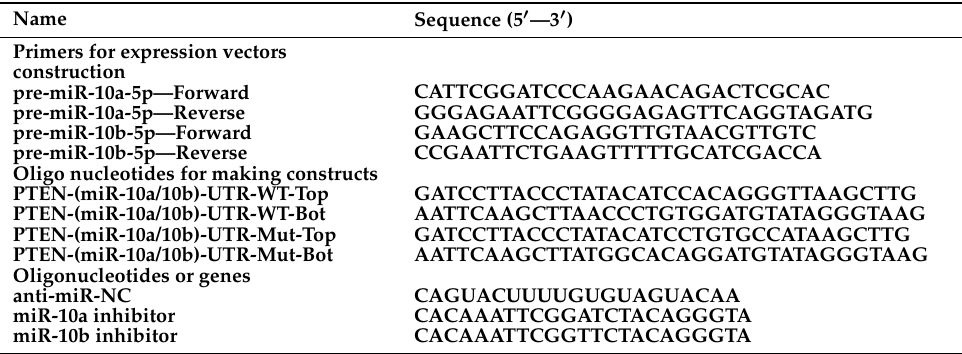
Table 1. Primers and